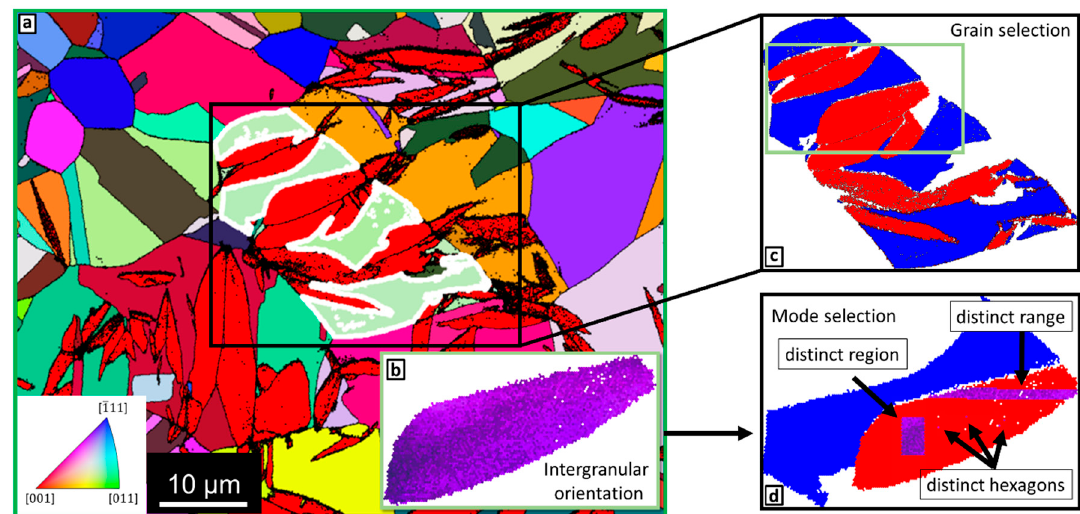
Figure 4. ( a ) Combined EBSD and phase map of FeNiC representing the mean austenite orientations as indicated by the inverse pole figure colour code with reference to the norm direction. The martensite is represented in red colour only. ( b ) Intergranular orientations of martensite and the corresponding austenite grain in ( c ); ( d ) distinct predefined range, individually selected rectangular area and individually predefined data points of the EBSD data within the martensite and the corresponding austenite grain. The white spots indicate non-indexed points.